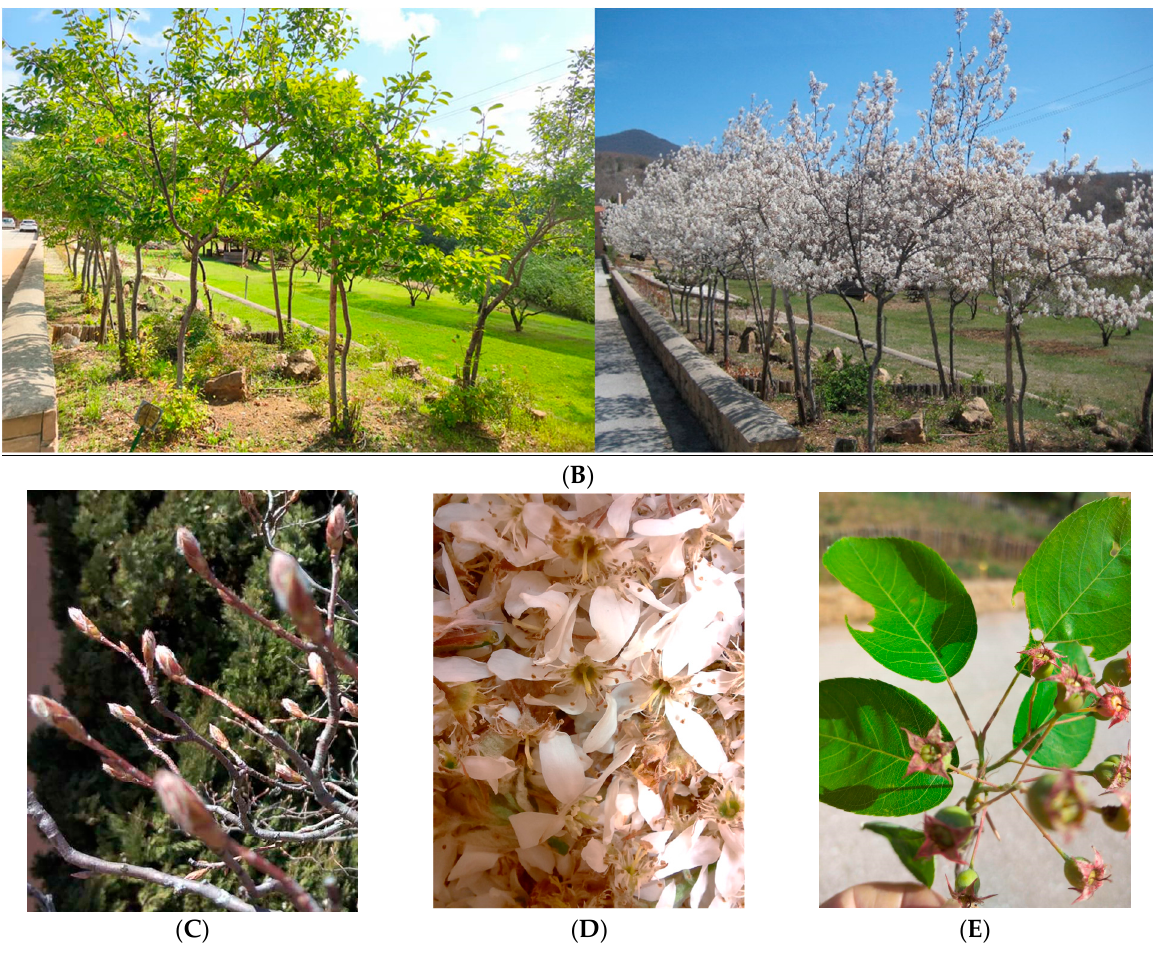
Figure 5. ( A ) Appearance of in situ adapted wild-growing young individual of Amelanchier ovalis subsp. ovalis GR-1-BBGK-19,928 from Mt. Tzena, Pella (northern Greece) thriving in an inclined rocky substrate; ( B ) Mature trees of Amelanchier ovalis subsp. ovalis GR-1-BBGK-04,2547 from Mt. Tzena (Pella, northern Greece) acclimatized ex situ at the grounds of the Balkan Botanic Garden of Kroussia (600 m above sea level); Young twigs ( C ), flowers ( D ), leaves and young fruits ( E ) of ex situ cultivated Amelanchier ovalis subsp. ovalis GR-1-BBGK-04,2547 from Mt. Tzena used for phytochemical evaluation.